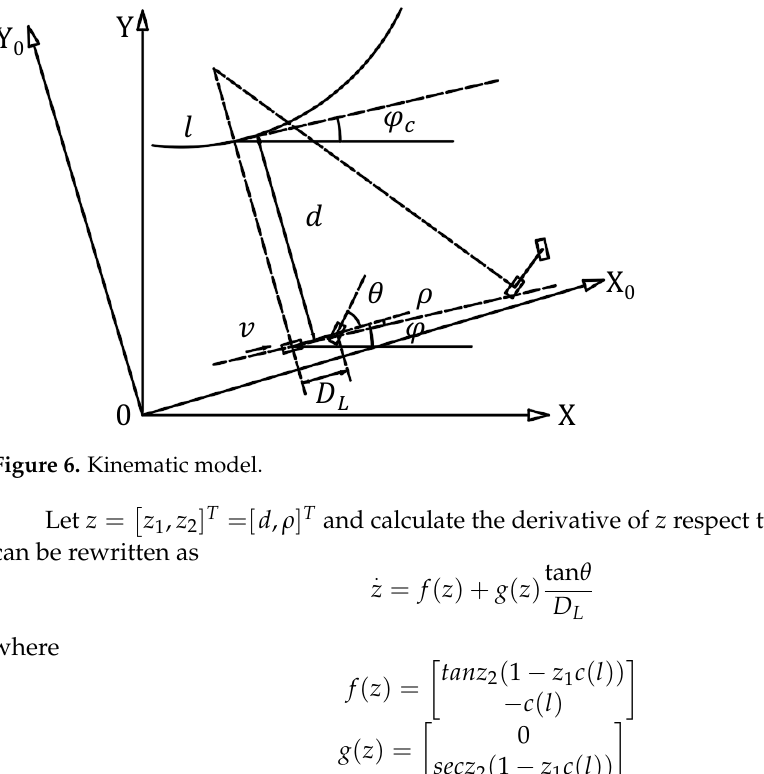
D L tracking curvature, respectively; = − ,  denotes the heading deviation and steering wheel angle, respectively; ( ) c l and v are the path arc length and speed of the rice transplanter, respectively.